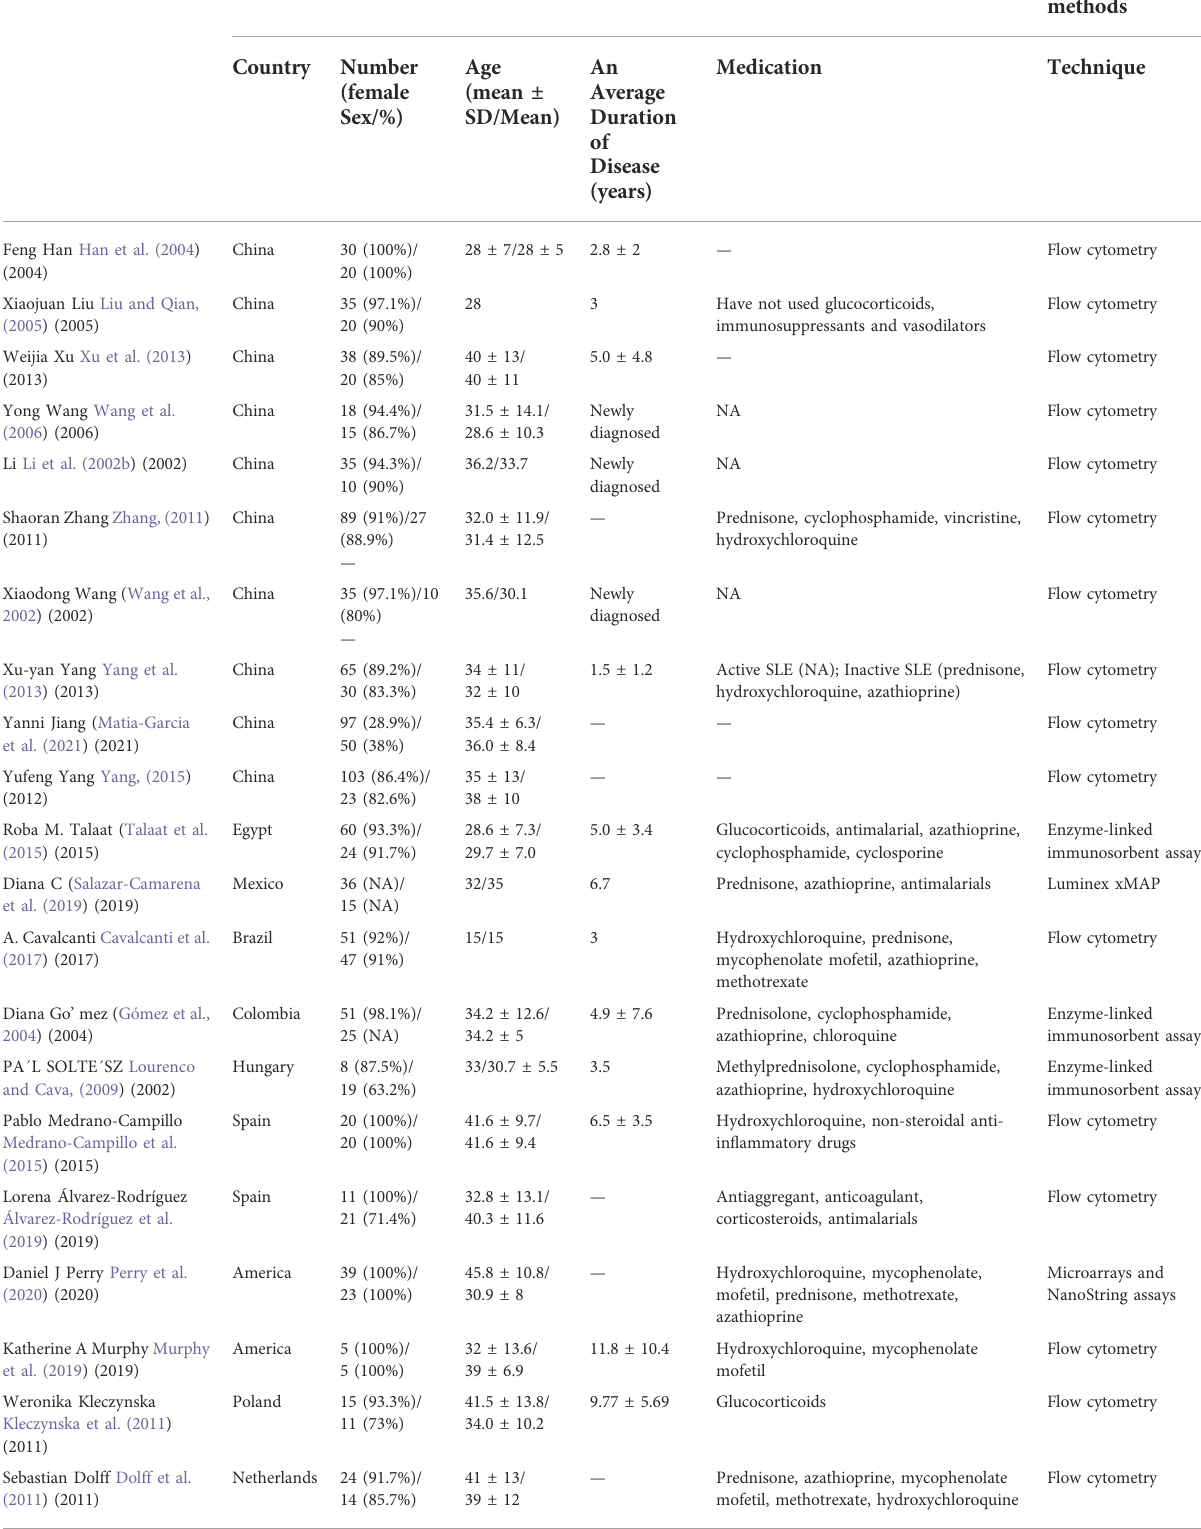
TABLE 1 The characteristics of included